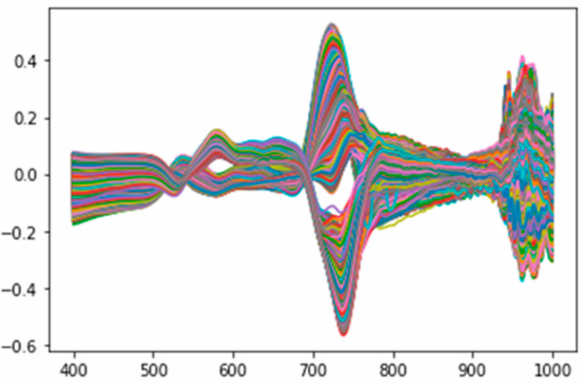
Figure A3. Spectrum corrected by centering. X-axis represents wavelength of feature (Unit: nm) while Y-axis represents standardized and centered reflection value. The color of lines represents each reflectance value of grass